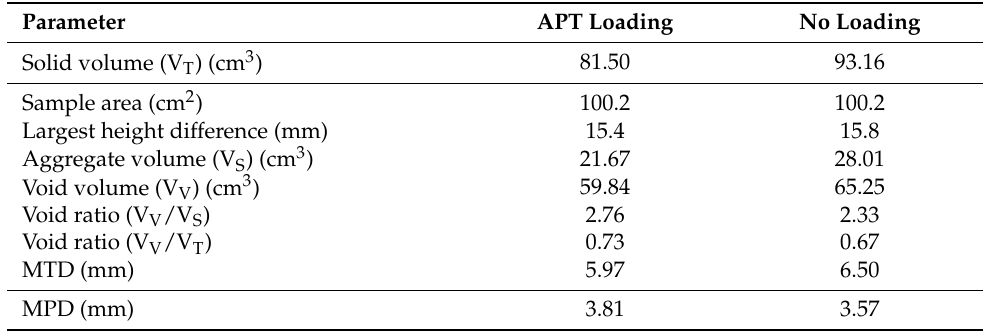
Table 3. Volume and void ratios calculated from a statistical analysis of the 3D data sets on the double seal shown in Figures 11 and 12.